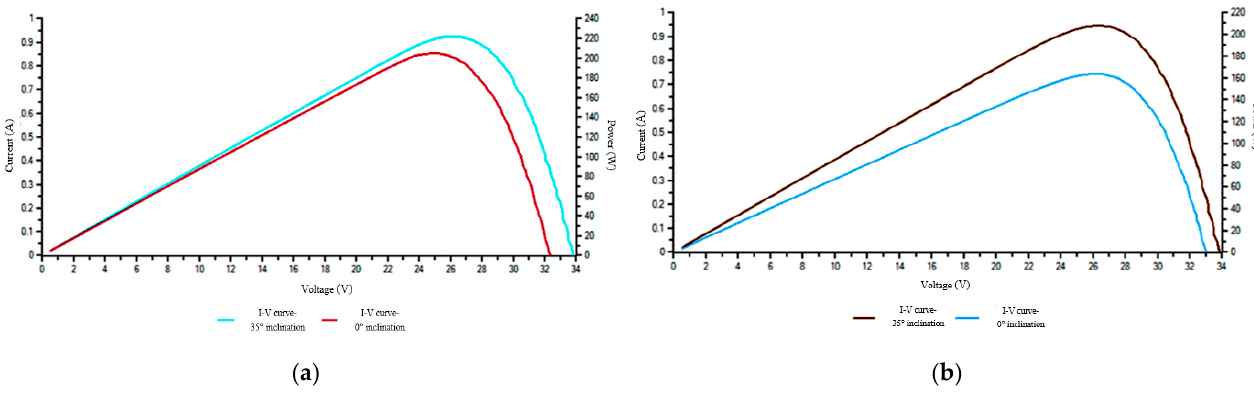
Figure 12. Voltage-current diagram of tilted and horizontal panels. ( a ) summer, ( b ) winter.